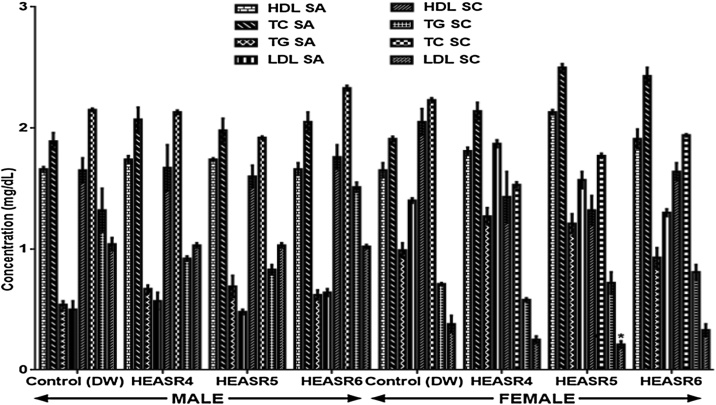
Effect of HEASR on lipid profiles levels in normal male Wistar rats. SA: Subacute, SC: Subchronic, HDL: High density lipoprotein, LDL: Low density lipoprotein, TC: Total cholesterol, TG: Triglyceride. Results are expressed as mean ± S.E.M. n: total number per group. n (SA) = 8, n (SC) = 12. Mortality: HEASR5 (8.3%, male), HEASR6 (16.67%, male), HEASR4 SC (8.3%, female), HEASR5 SC (16.7%, female) and HEASR6 SC (25%, female). *p < 0.05 or **p < 0.01 when compared with control (distilled water: DW, 10 mL/kg) group. HEASR4: 250 mg/kg, HEASR5: 500 mg/kg, HEASR6: 1000 mg/kg, HEASR: hydroethanolic extract of A. smeathmannii root.